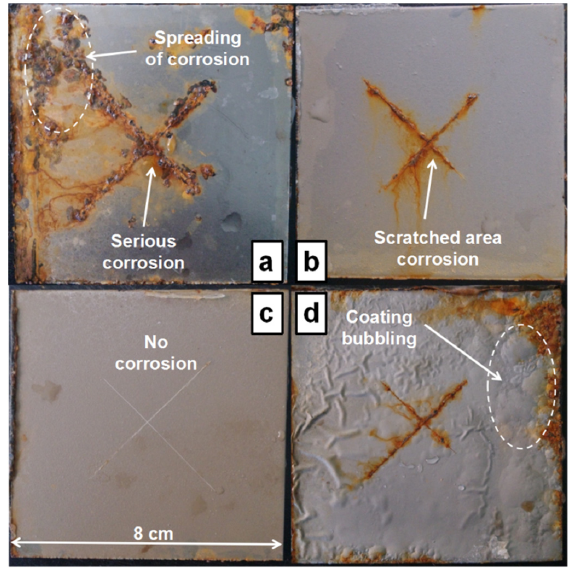
Figure 8. Salt spray tests results of ( a ) pure epoxy coating, ( b ) OTiO 2 (w) epoxy coating, ( c ) iETiO 2 (w) epoxy coating, ( d ) a commercial anti ‐ corrosion coating (Rust Bullet).